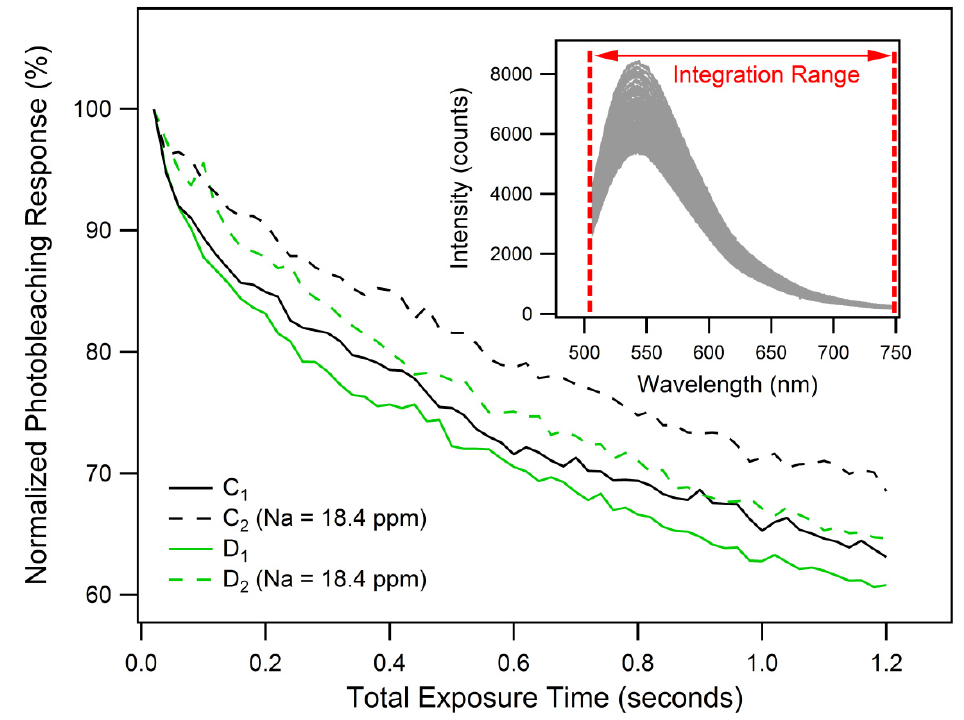
Figure 5. Normalized photobleaching response of the PET-based MOF dip sensor. Traces and D show the background photobleaching responses of the analyte solution without C 1 1 and D depict the corresponding PET-fluorescence responses of the sodium ions; traces C 2 2 analyte solution spiked with sodium ions (Na + = 18.4 ppm). The inset shows the series of 60 successively acquired fluorescence spectra (each an average of 8 signal waveforms with a total pump beam exposure time of 0.02 s), integrated from 505–748 nm and normalized of Figure to generate trace D 2